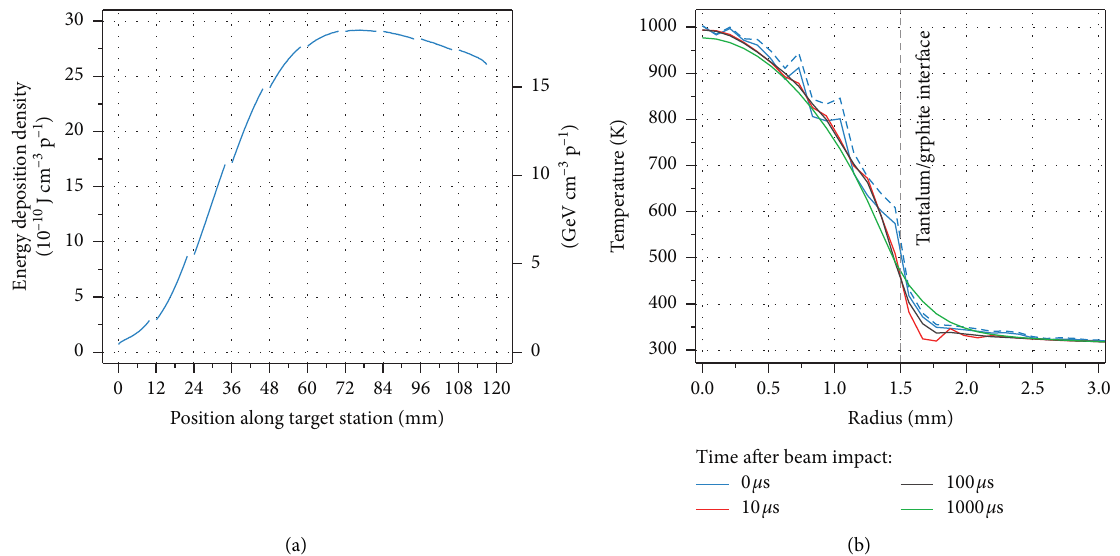
Figure 3: Energy deposition density and simulated temperature distribution. Peak energy deposition density in the transversal plane per primary 440GeV proton for an inhomogeneous Gaussian intensity profile with σ H � 1.46mm and σ V � 1.02mm in the tantalum cores along the length of the sample stack (a). Simulated radial temperature distribution in the horizontal plane and center of sample #6 for different times after beam impact by a single pulse of 6 × 10 11 protons (300 ns). The dashed line indicates the radial temperature distribution in the vertical plane directly after beam impact (b).